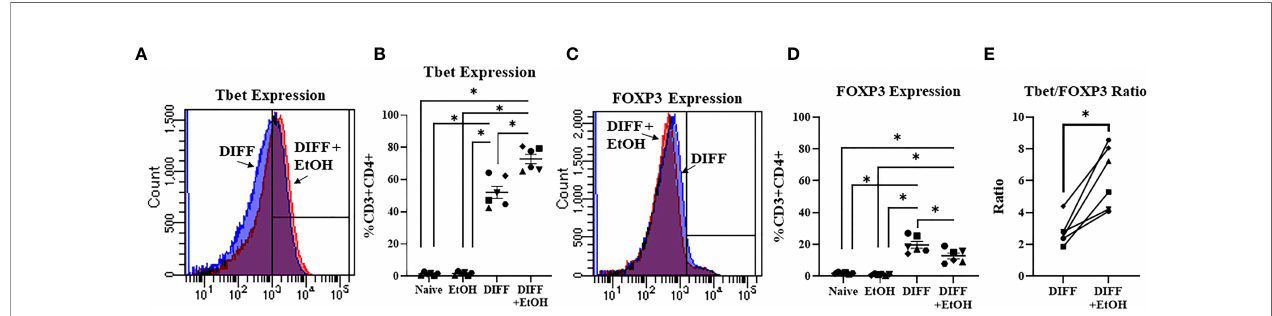
FIGURE 2 | Effect of ethanol on CD4 + T cell differentiation. (A) Representative FACS histograms of Tbet expression in DIFF and DIFF + EtOH CD4 + T cells. (B) Ethanol increased percent of CD4 + Tbet-expressing cells. (C) Representative FACS histograms of FOXP3 expression in DIFF and DIFF + EtOH CD4 + T cells. (D) Ethanol decreased percent expression of FOXP3 in CD4 + T cells. (E) Ethanol increased the Tbet/FOXP3 ratio in differentiated CD4 + T cells. Naïve = undifferentiated and no ethanol treatment, EtOH = undifferentiated and ethanol-treated, DIFF = differentiated and no ethanol treatment, and DIFF + EtOH = differentiated and ethanol-treated. Data are average values for 3 independent experiments using CD4 + T cells from 6 donors expressed as mean ± SEM. Signi fi cant differences (p<0.05) were determined by repeated measures 2-way ANOVA (Panels B, D ) and paired T-tests (Panel E ).*p